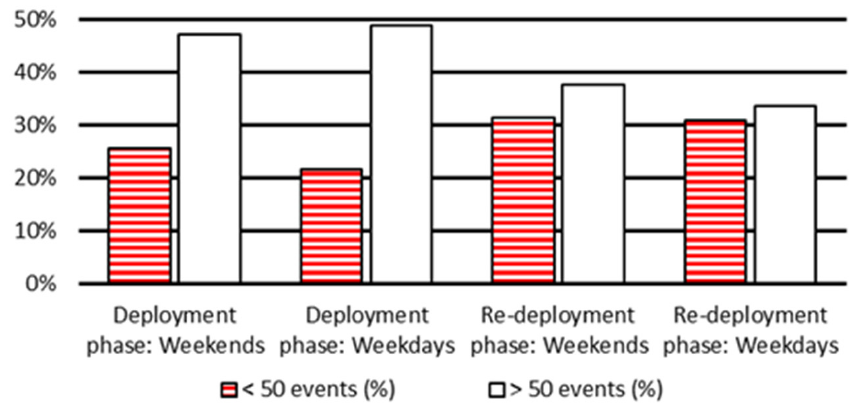
Figure 16. The average percentage of hours in a day for three activity levels of more than 50, less than 50, and no event for deployment and re-deployment testbed during weekdays and weekends.